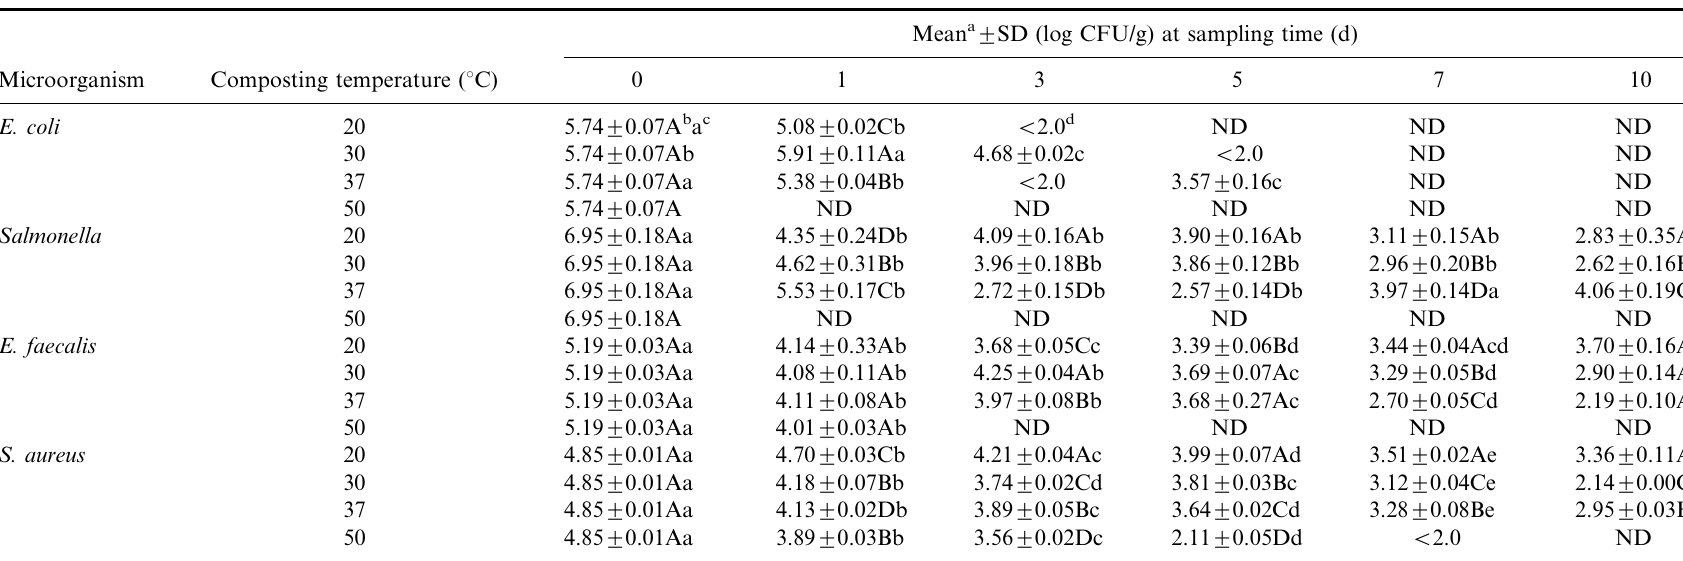
Table 1. The survival and persistence of E. coli , Salmonella , E. faecalis , and S. aureus during cattle manure composting with addition of 2.0% CaCN 2 at different temperatures